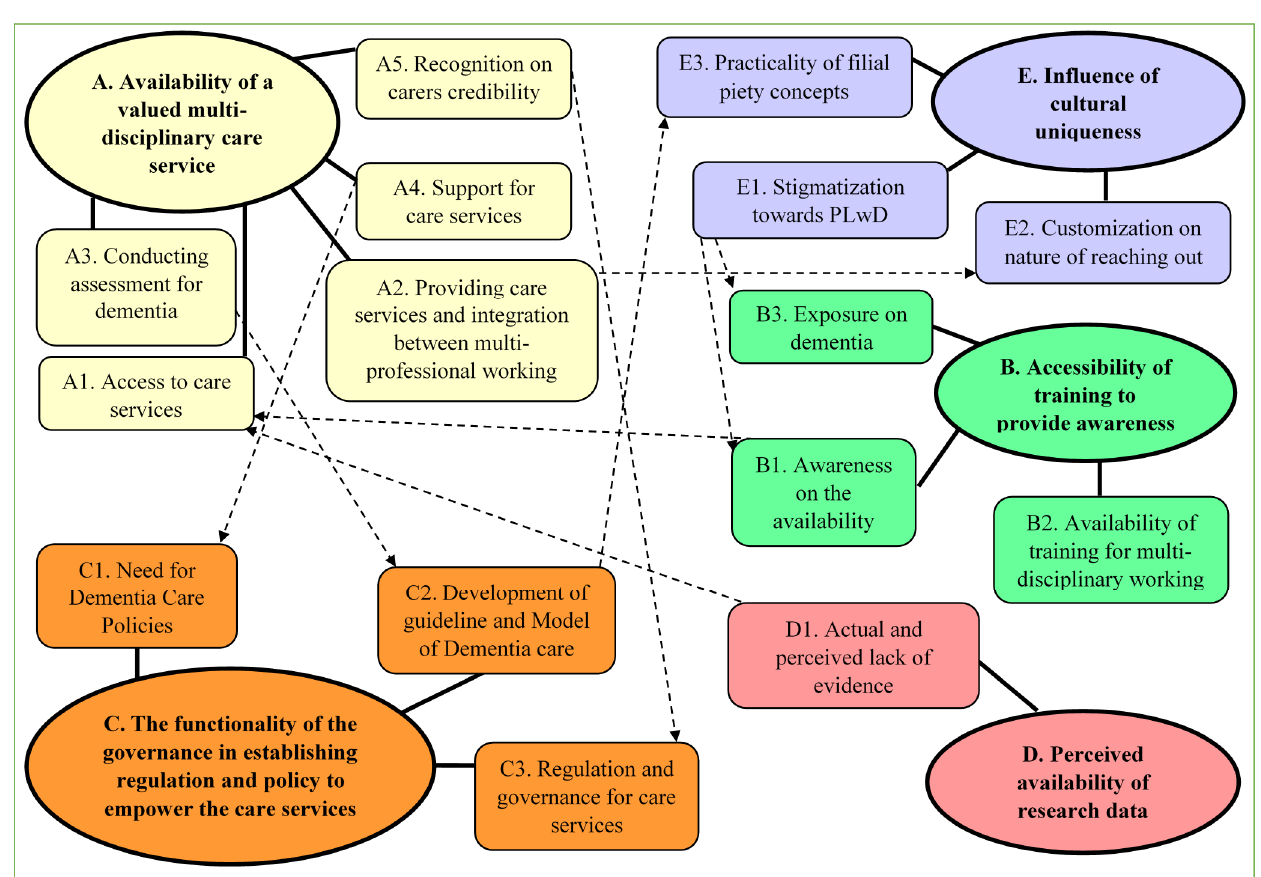
Figure 2. Constructed themes relationship.